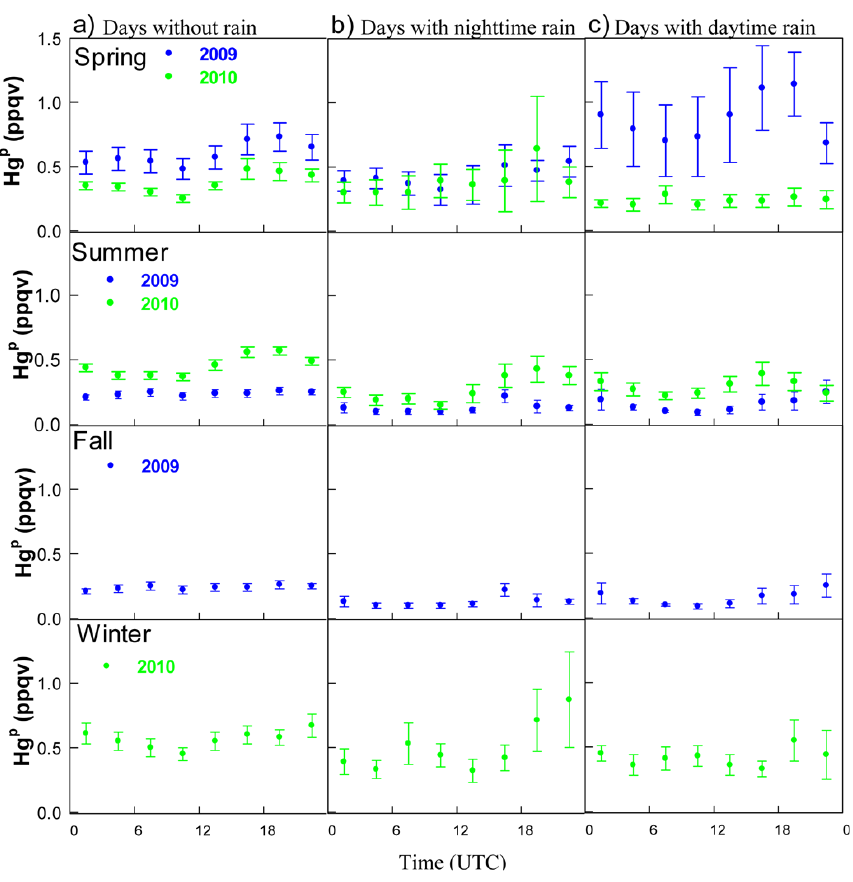
Fig. 16. Diurnal cycles of Hg P at TF (coastal) averaged over days without rain (a) , days with nighttime rain (b) , and days with daytime rain (c) for all seasons during 2009–2010. Precipitation in winter includes rain and snow. Local nighttime is about 00:00–11:00UTC, daytime 12:00–23:00UTC, and noontime is 16:00UTC during the Daylight Saving period of the year and 17:00UTC